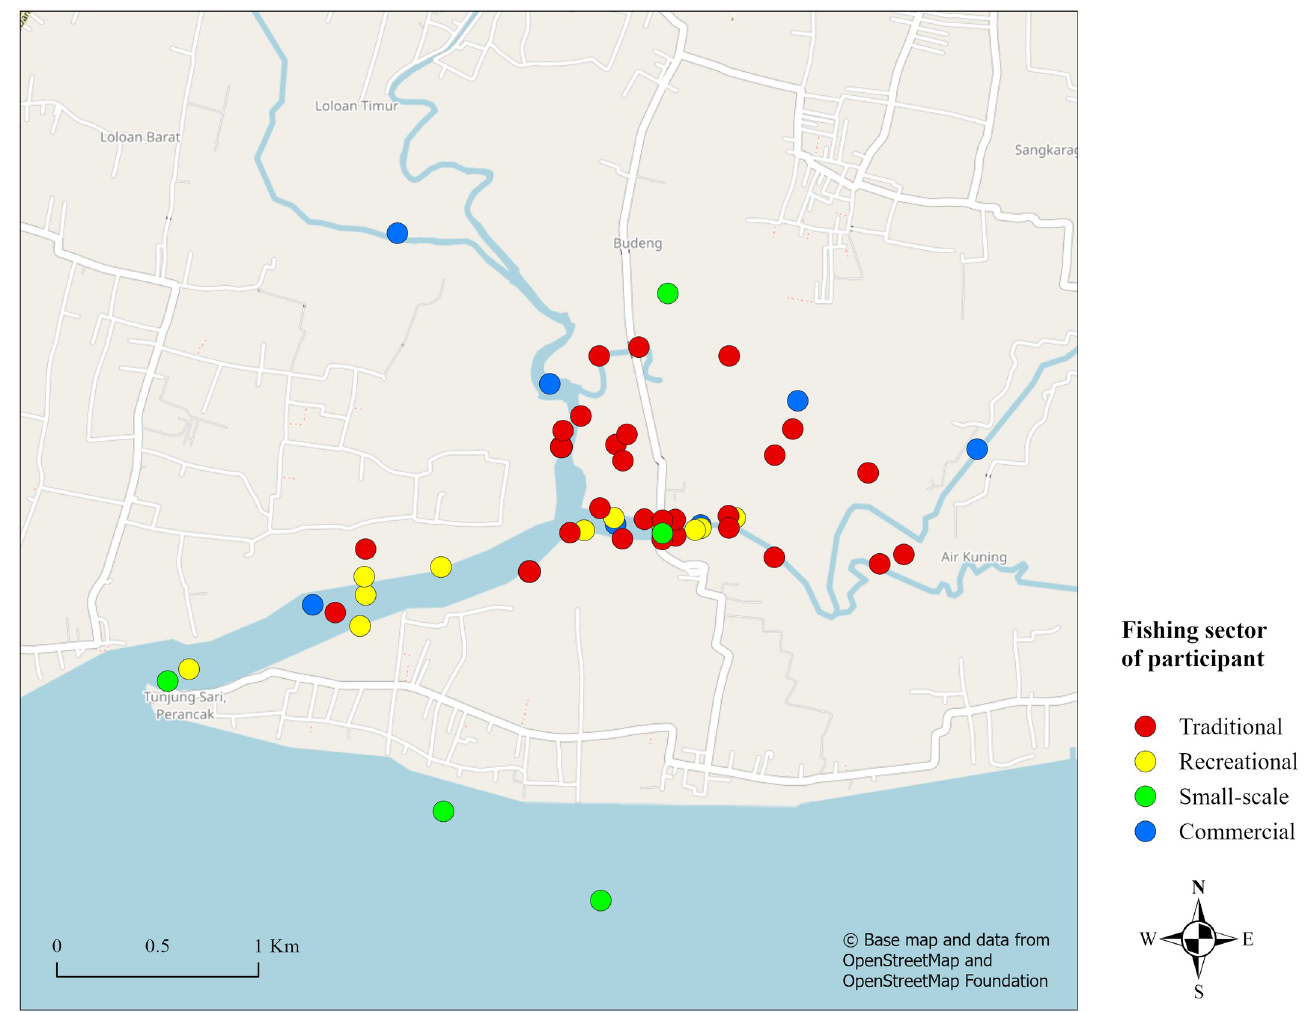
Fig 3. Fishing location by sector based on participatory mapping by fishers and other stakeholders in the Perancak estuary area of the Jembrana Sub- district, Jembrana Regency, Bali. Sectors included are traditional, small-scale, commercial and recreational fishing. For the location of the Perancak estuary in Bali see Fig 1. Sectors refer to groups of fishers who identify as belonging to the sector, as opposed to representing activity of the sector itself. The base map and data were sourced from OpenStreetMap and OpenStreetMap Foundation. This figure contains information from OpenStreetMap and OpenStreetMap Foundation, which is made available under the Open Database License. This map was created using ArcGIS Pro